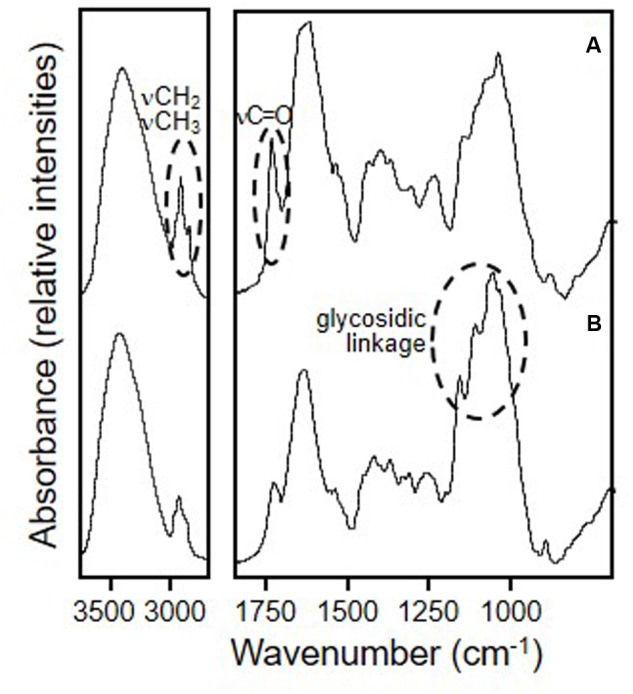
Fourier transform infrared spectroscopy spectra of freeze-dried okara.
(A) whole okara; (B) defatted okara. Slashed circles denote the main differences between both spectra.